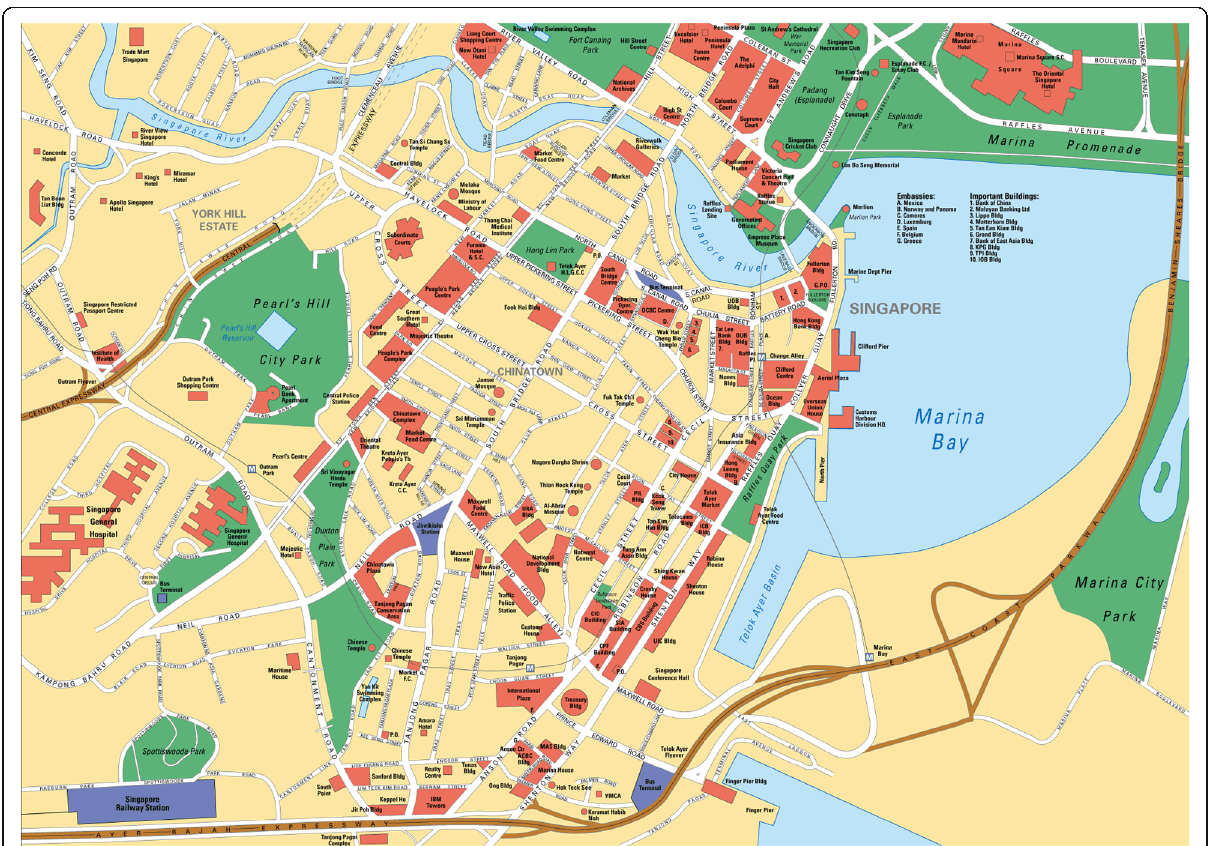
Fig. 2 An actual roadmap. This figure is a sample